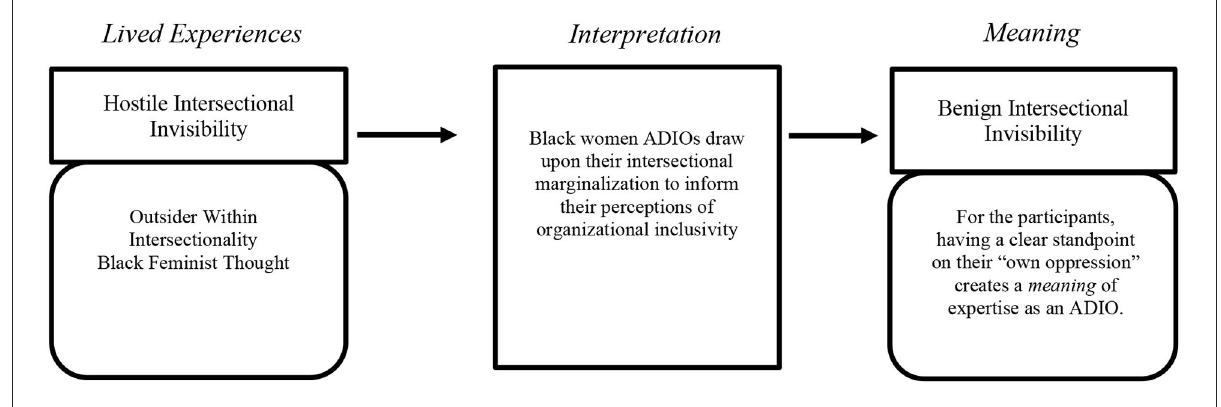
FIGURE1 Meaning making of organizational inclusivity in black women